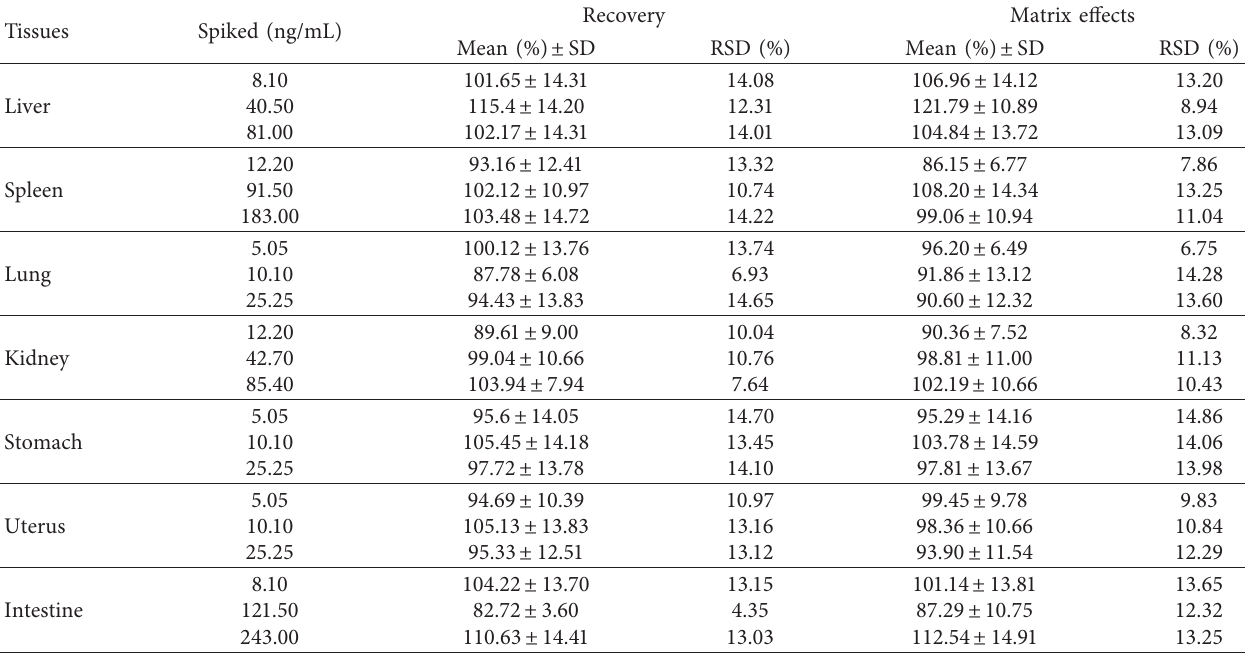
Table 16: Recovery and matrix effect study of kaempferol in rat tissues ( n � 6).